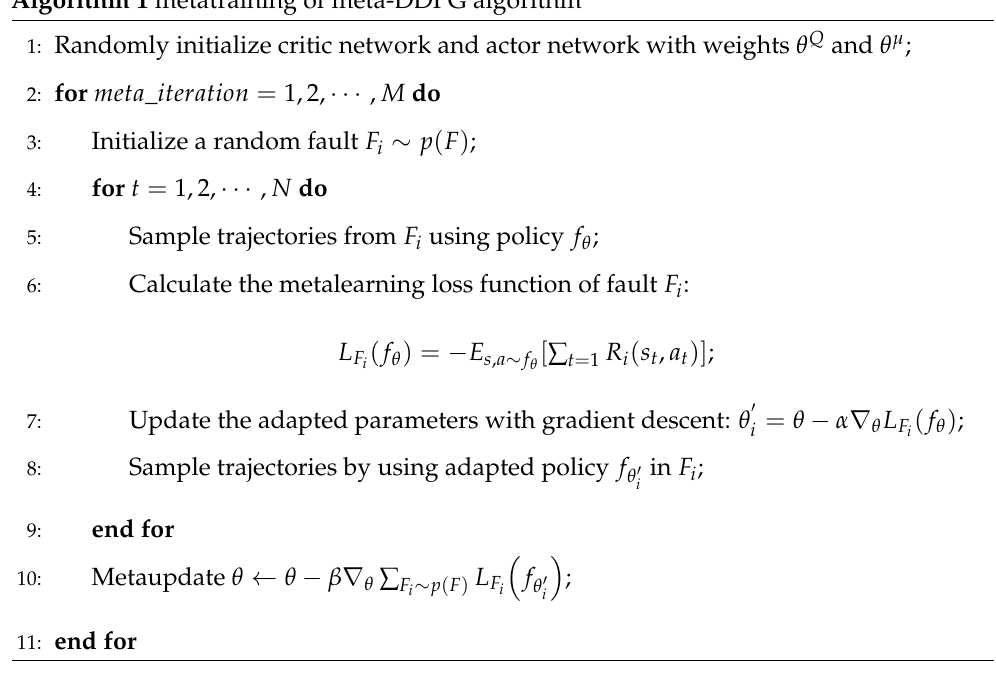
Algorithm 1 metatraining of meta-DDPG